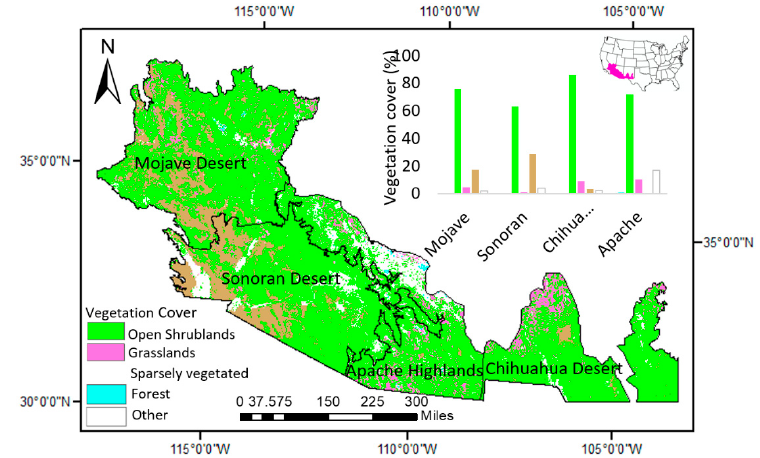
Figure 1. The study area showing the four ecoregions data from the nature conservancy [24]: the Mojave, Sonoran, and Chihuahuan Deserts and the Apache Highlands. The major percentage of vegetation cover based on MODIS land cover classification [28] is shown in the bar graph. The color of vegetation types in the bar graph is the same as used in the map and legend.